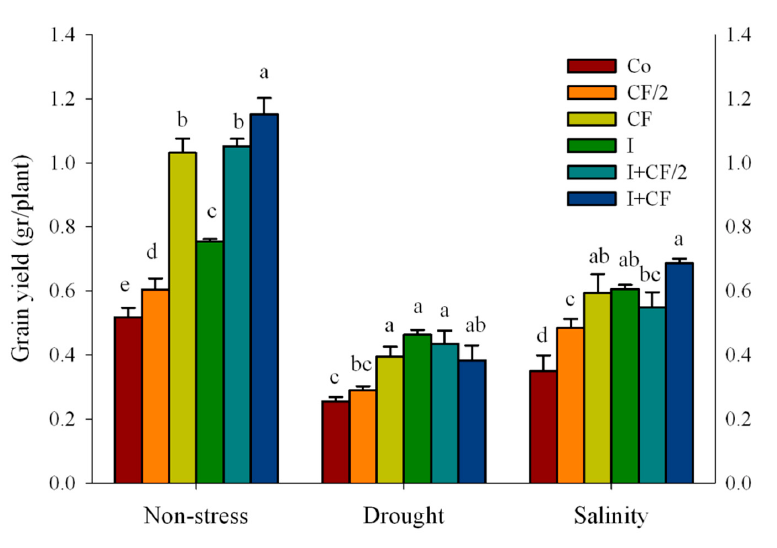
Figure 1. Grain yield in response to the chemical / microbiological fertilization managements under non-stress, salt, and drought conditions. Co: Control (no PGPB (plant growth-promoting bacteria) inoculation and no chemical fertilizer); I: Seed inoculation with the selected PGPB consortium (bacterial suspension was also added to pots every 3 weeks); CF: Soil treated with full dose of chemical fertilizer; CF / 2: Half dose of chemical fertilizer; I + CF and I + CF / 2: Inoculation and chemical fertilization. Means on the bars marked by the same letter(s) are not significantly di ff erent based on the least significant di ff erence (LSD) test at 0.05 probability